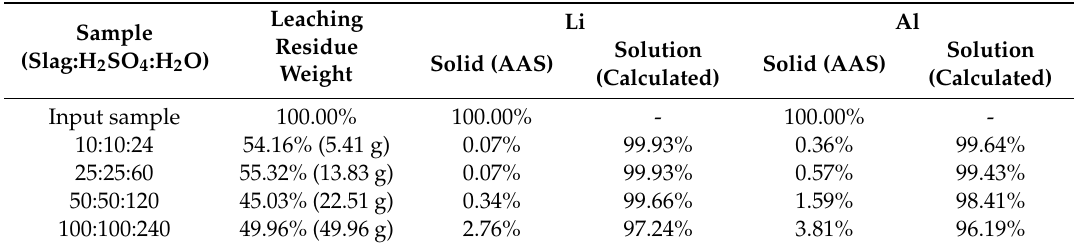
Table 6. Solid sample atomic absorption spectrometry (AAS) analysis and calculated dissolution rate of lithium and aluminum.